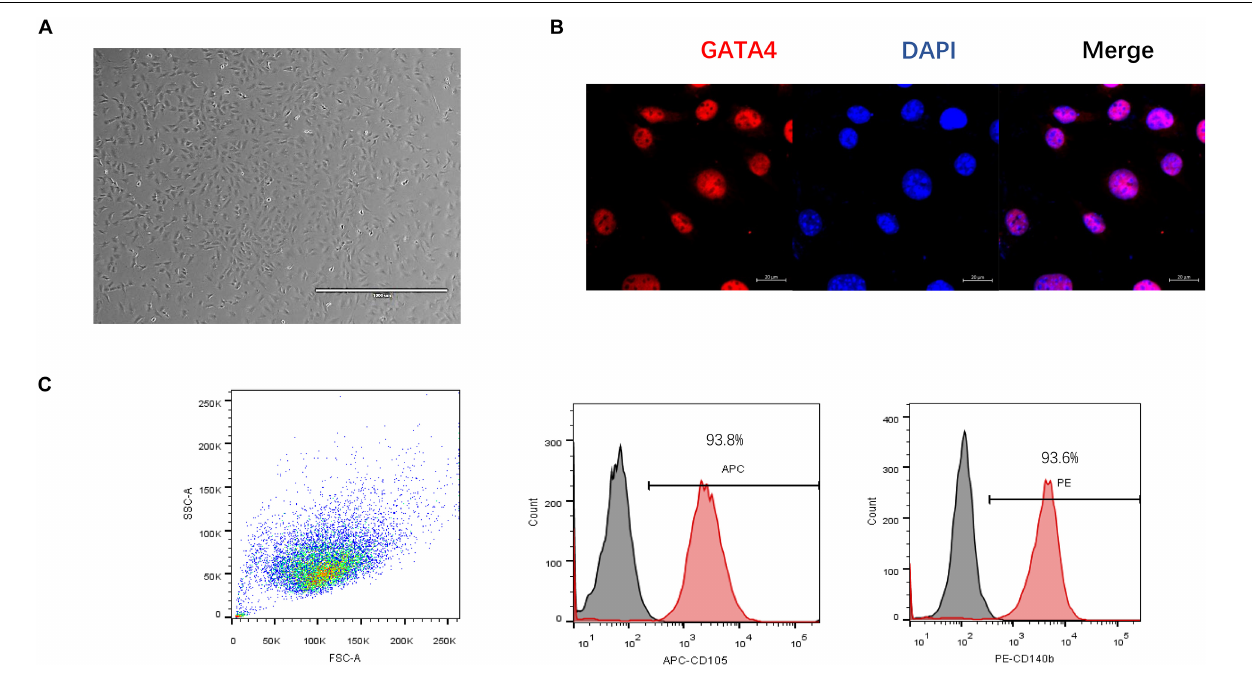
FIGURE 1 | Phenotypic characterization of C-MSCs. (A) Cultured C-MSCs at passage 10, scale bar = 1000 µ m. (B) Immunofluorescent staining of GATA4, a marker for early cardiac transcription factor (red); cell nuclei were counterstained with DAPI (blue) (scale bar = 20 µ m). (C) Flow cytometric analyses of C-MSCs for the profile of the cell surface markers CD105 and